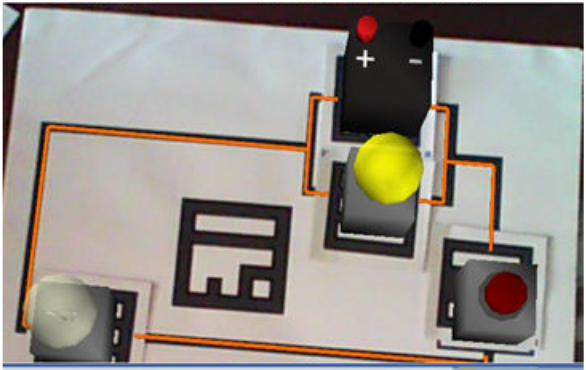
Figure 2. Electrical circuit using augmented